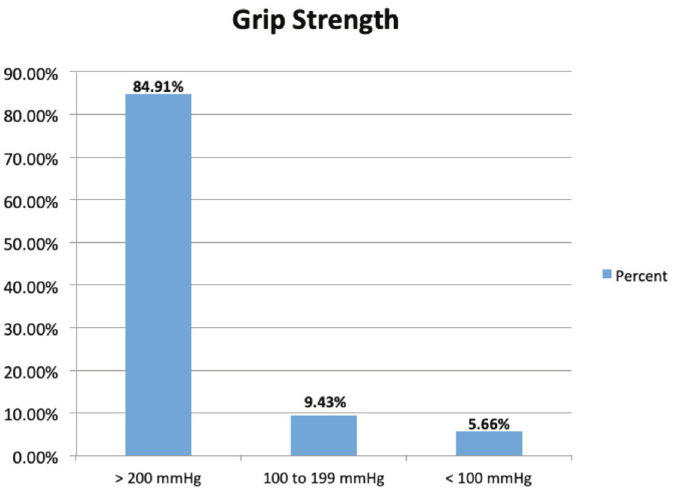
Fig. 4: Demonstrates grip strength after tendon